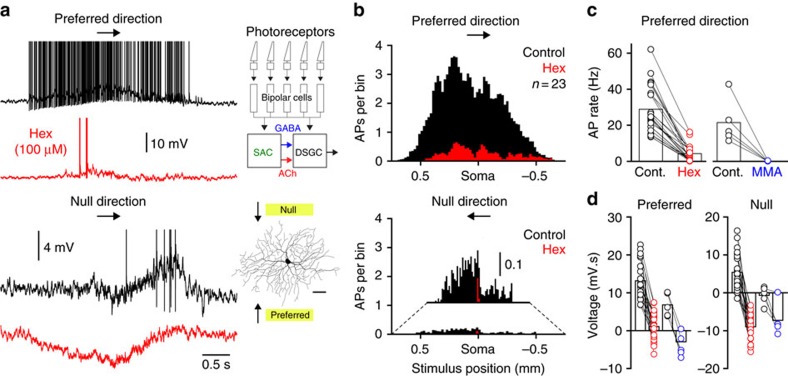
Cholinergic signalling powerfully controls the light-evoked action potential output of ON-DSGCs.(a) Physiological activation of the retinal microcircuit (summarized in the inset schematic) by light bars moved across the receptive field of an ON-DSGCs (inset morphological reconstruction) leads to the generation of powerful action potential (AP) firing when moved in a preferred direction, but sparse AP output when moved in a null direction (control, black traces, APs have been truncated for clarity). The antagonism of nAChRs leads to a reduction of preferred direction light-evoked AP firing and the generation of pure inhibitory responses when light stimuli are moved in the null direction (hexamethonium (Hex); red traces). (b) Peri-stimulus histogram of preferred and null direction light-evoked AP firing under the indicated conditions (bin size 20 μm). (c) Quantification of the reduction of preferred direction light-evoked AP firing by nAChR antagonists (mecamylamine (MMA); blue symbols). (d) Quantification of the voltage integral of median filtered (10 ms) preferred and null direction light responses under the indicated conditions (control versus Hex: preferred: P<0.0001, T=10.19; null: P<0.0001, T=11.47; control versus MMA: preferred: P<0.0001, T=15.86; null: P=0.0038, T=6.02). All light stimuli were applied under photopic conditions. Stimulus intensity was twice that of background illumination.